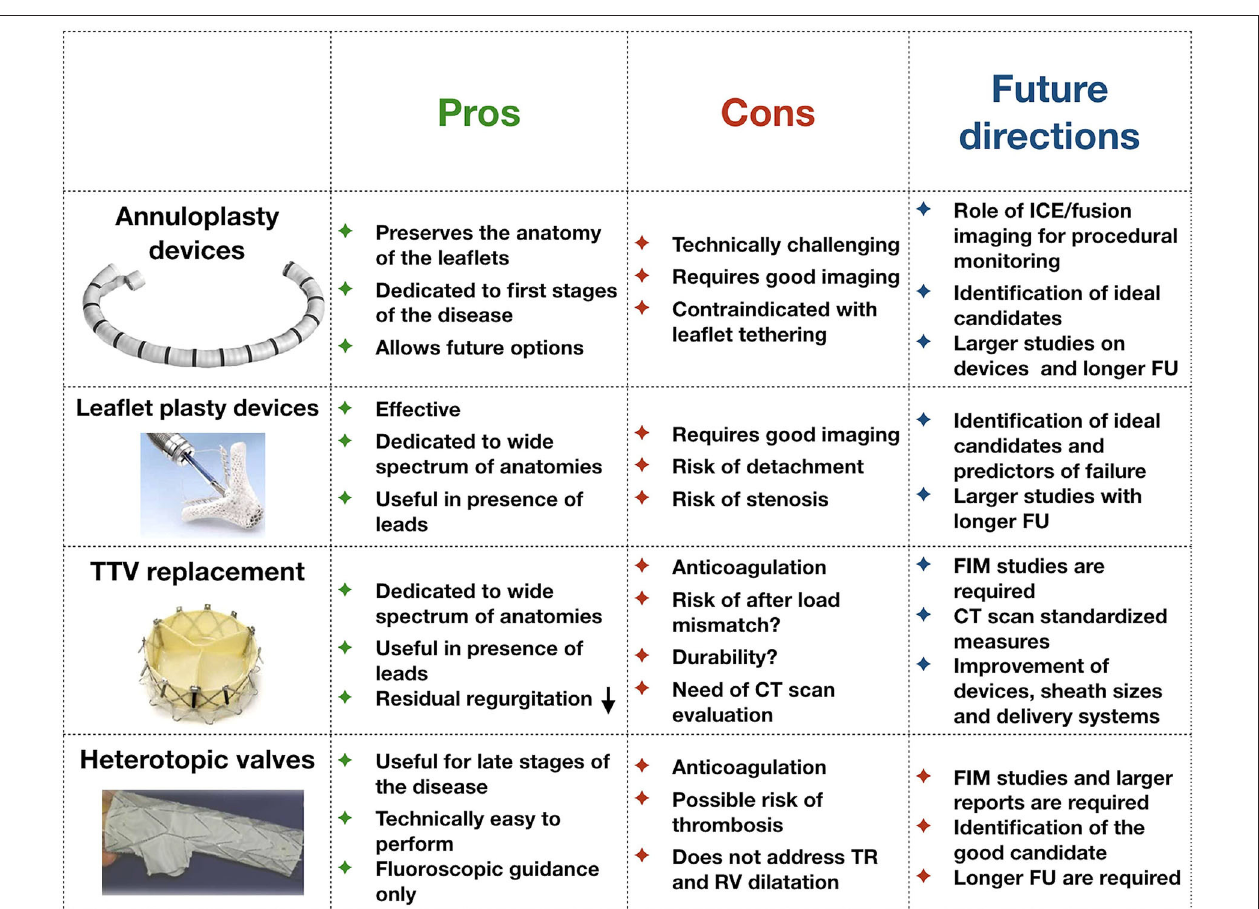
(14, 23). However, the following points need to be